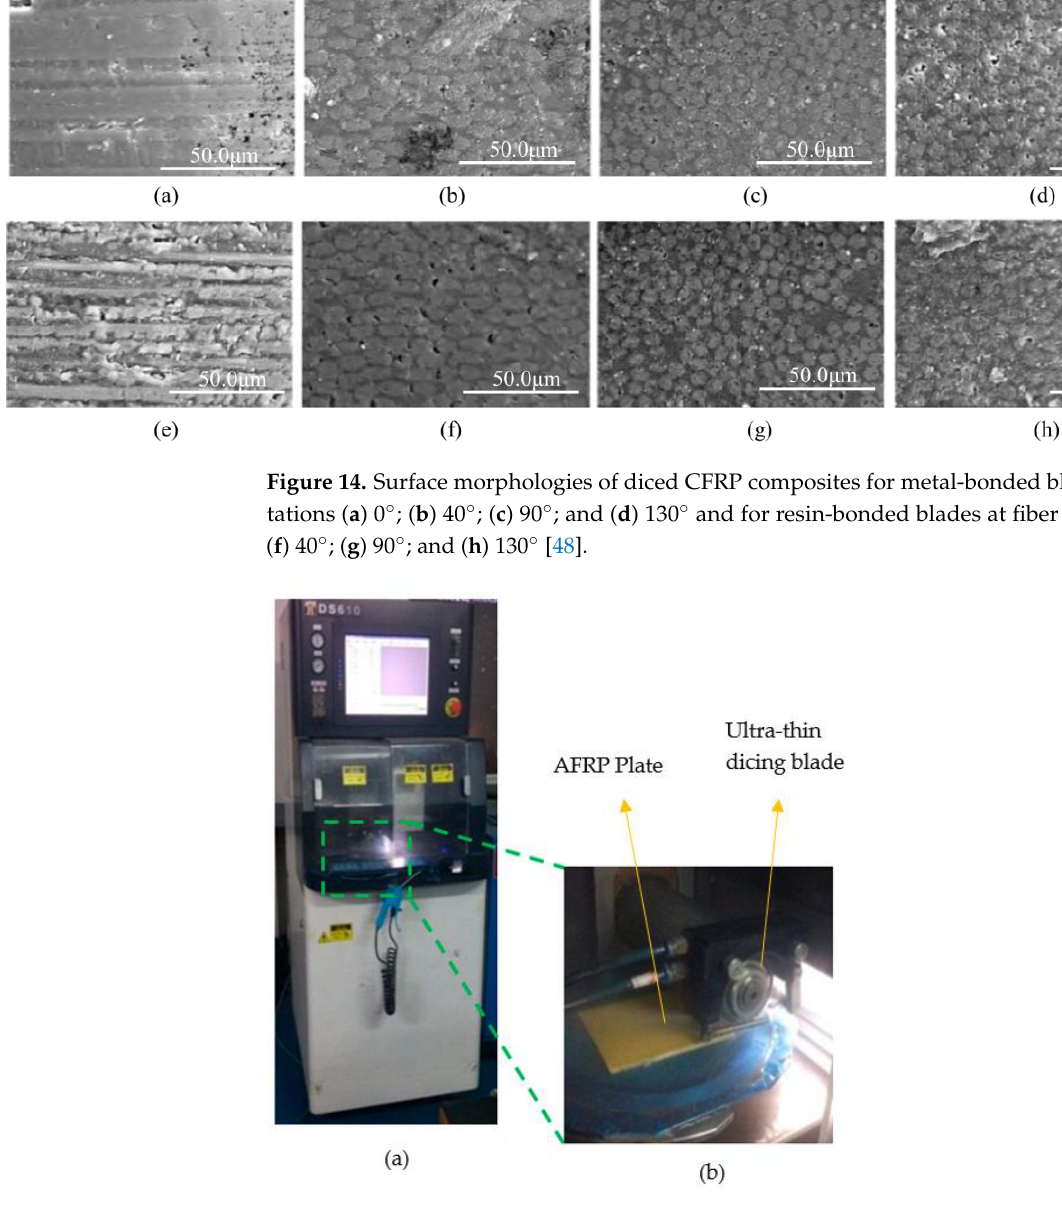
Figure 15. Dicing AFRP composite fiber with dicing machine [52]. ( a ) Dicing machine; ( b ) tool and workpiece